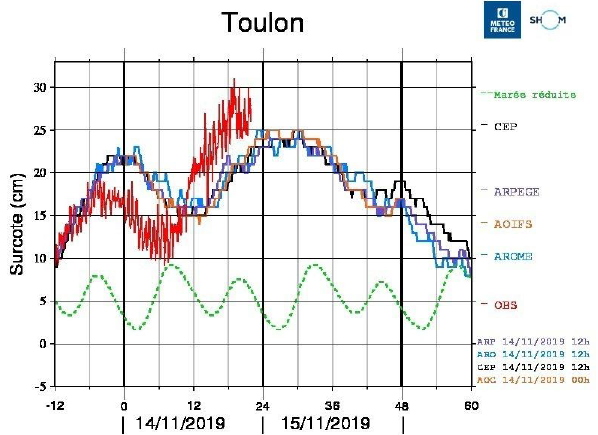
Figure 4. Temporal series (every 10min) for the storm surge fore- casted at Toulon (south of France) starting on 14 November 2019 at 12:00UTC using the forcing provided by the global model IFS from ECMWF (named CEP, black), by the global model ARPEGE from Météo-France (purple), by the Météo-France LAM model AROME nested in ARPEGE (AROME) (blue) and by the Météo-France LAM model AROME-IFS nested in IFS (orange). Red: tide gauge observations; green: tide height